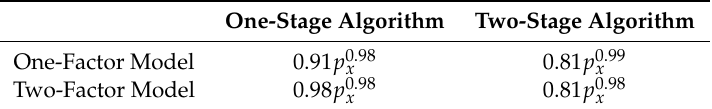
Table 1. This table reports fitted values of the relationship ν x ≈ ap b x for each estimator (one- and two-stage) and each model (one- and two-factor). Values of a and b are obtained by determining the line of best fit on the logarithmic scale (i.e., the line appearing in Figure 6). Note that in the absence of (cid:112) p x ( 1 − p x ) ≈ p 0.5 x IS we would have ν x =